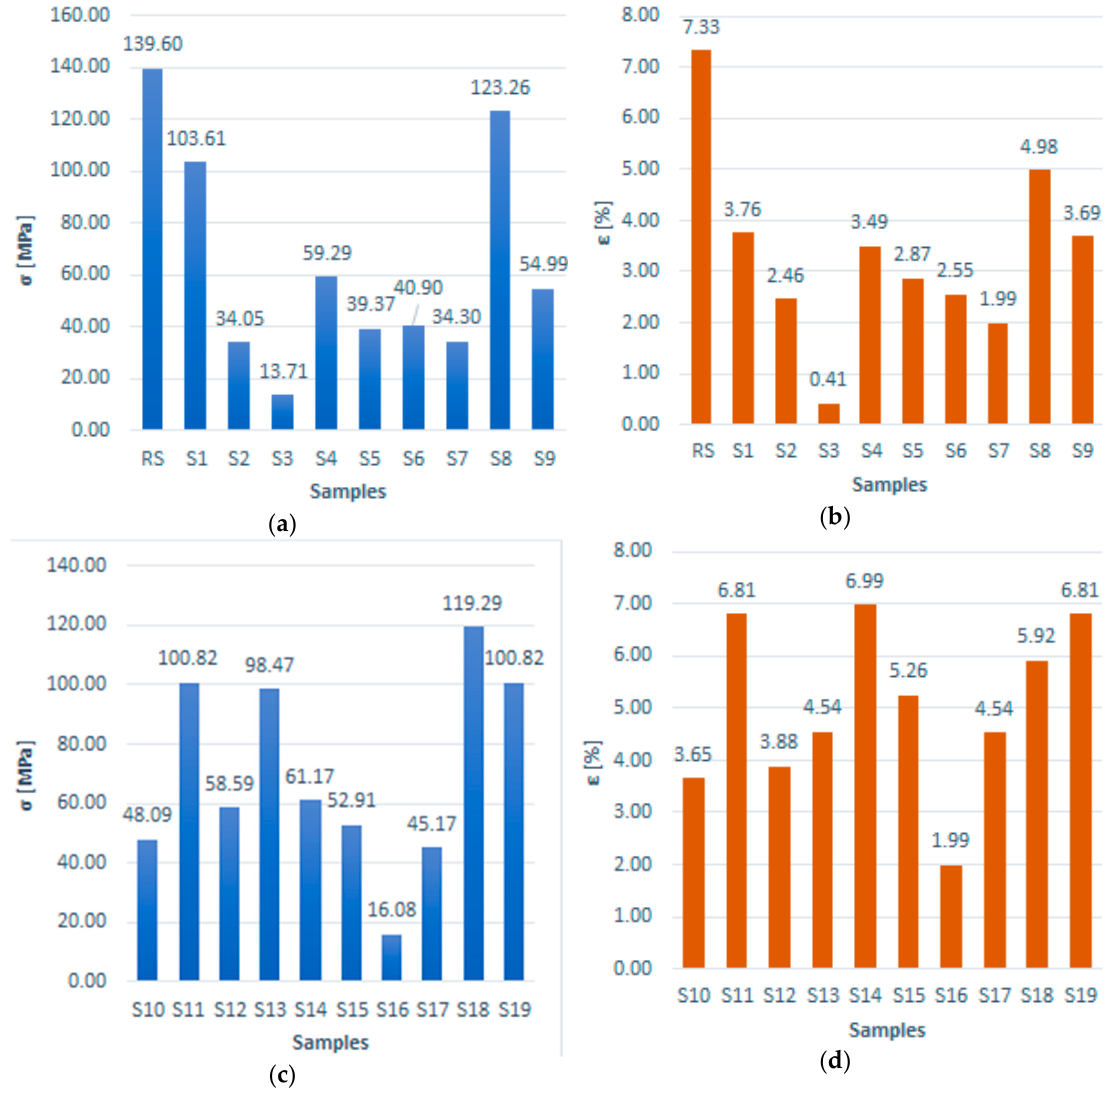
Figure 12. Results from the tensile tests: ( a ) Ultimate tensile strength (samples 1 to 9); ( b ) Strain associated with the ultimate tensile strength (samples 1 to 9); ( c ) Ultimate tensile strength (samples 10 to 19); ( d ) Strain associated with the ultimate tensile strength (samples 10 to 19). (Note: RS means “reference sample” whereas S1 from S19 are the samples from 1 to 19).